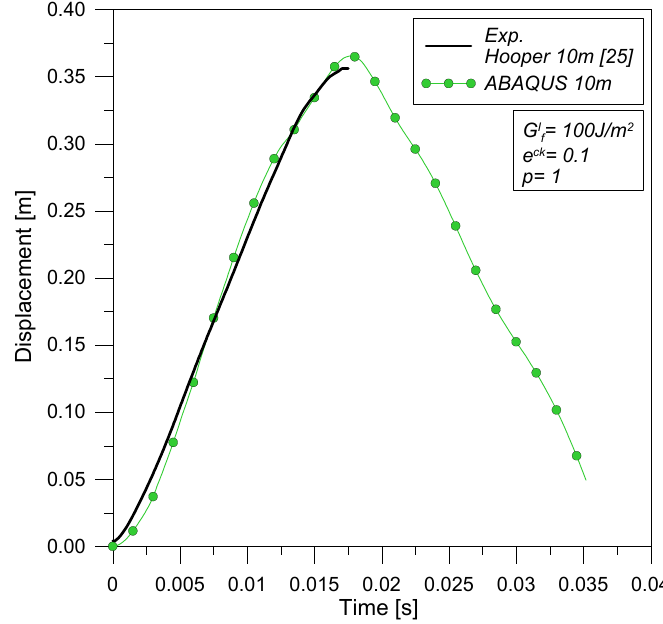
Figure 11. Deflection at the center of pane. Experimental (Hooper, [25]) and numerical (ABAQUS) results.